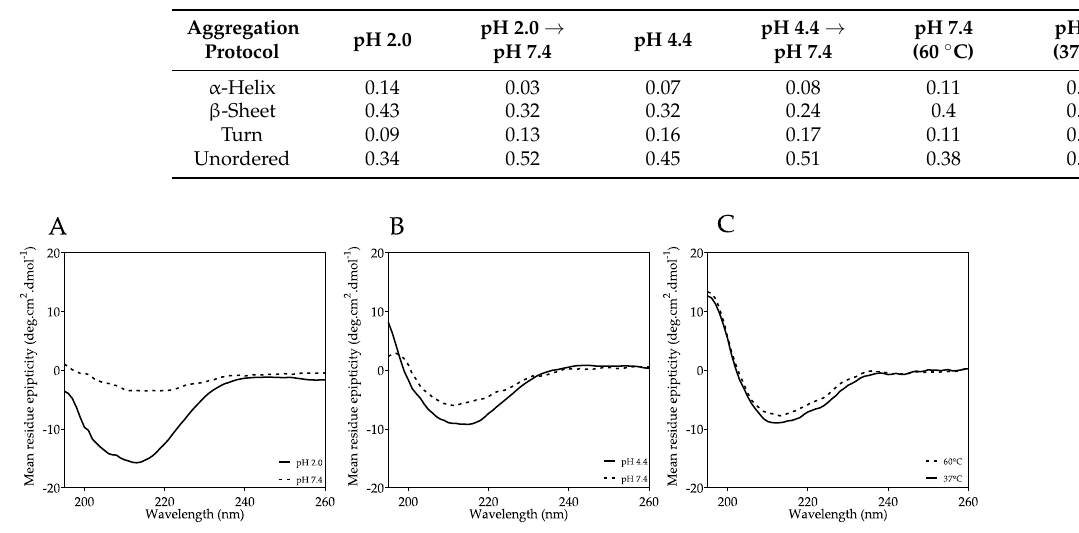
Figure 1. Far-UV CD spectra of TTRwt fibrils from different fibril formation protocols. ( A ) TTRwt fibrils assembled at pH 2.0 and after pH adjustment to 7.4, ( B ) at pH 4.4 and after pH adjustment to 7.4, and ( C ) at pH 7.4 at 60 °C and after temperature change to 37 °C. All TTRwt samples were analysed at 3.6 μ M and all CD spectra were acquired at the end of each fibril formation protocol.